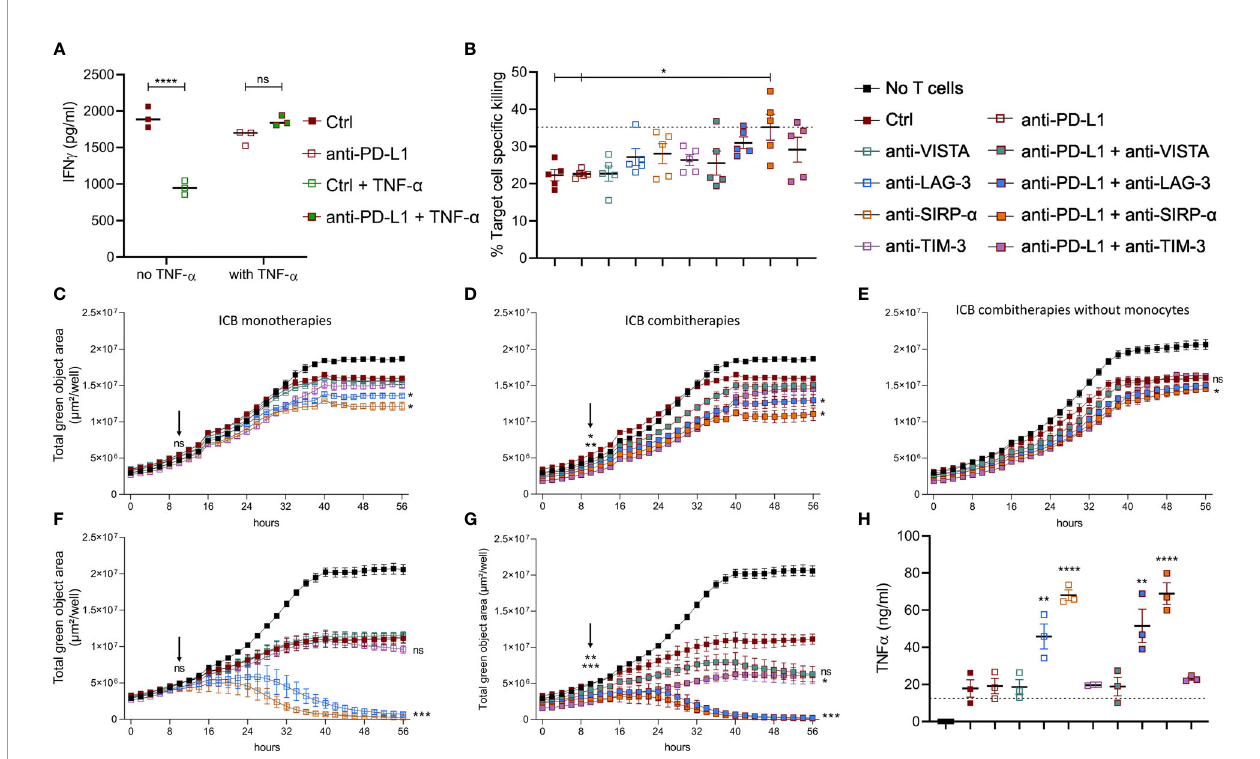
FIGURE 6 | Anti-PD-L1 therapy depends on monocytes to stimulate CTLs in combination with alternative ICBs. (A) Dot plot depicting IFN- g concentrations in supernatants from splenocytes 72 hrs after their incubation with 10 μg/ml Ctrl or anti-PD-L1 mAbs, with or without 1 μg/ml recombinant TNF- a (n=3). (B – H) depict results from LLC speci fi c OT-I killing assays, in the presence of Ly6C + monocytes sorted from lung tumor-bearing mice, no monocytes, or bone marrow derived monocytes resp. Moreover, the following conditions were compared: no monocytes + Ctrl mAb (dashed line in panels B and H), anti-PD-L1, -VISTA, -LAG-3, -SIRP- a , or -TIM-3 monotherapy (C, F) or their combination with anti-PD-L1 mAb (D, E, G) . (B) Percentages of cell-speci fi c killing 3 days after experiment onset (n=1, 5 mpc). (C – G) Follow-up of target cell con fl uency via total green object area (μm²/well) during the respective LLC-speci fi c OT-I killing assays over a time range of 56hrs. Images were obtained via Incucyte live cell imaging and statistical signi fi cances (on time points 10 and 56hrs) were calculated using a two-way ANOVA followed by a Dunnett ’ s multiple comparison test compared to the Ctrl mAb condition. (H) Dot plot depicting TNF- a concentrations in supernatants from the LLC- speci fi c OT-I killing assays shown in (F, G) at the 56hrs time point (n=3). Asterisks indicate signi fi cant differences between the marked conditions and the Ctrl mAb- treated condition. In panels (A, B, H) a one-way ANOVA with Tukey ’ s multiple comparison test was used to test for statistical signi fi cance. ns, non-signi fi cant; * for p < 0.05; ** for p < 0.01; and **** for p <